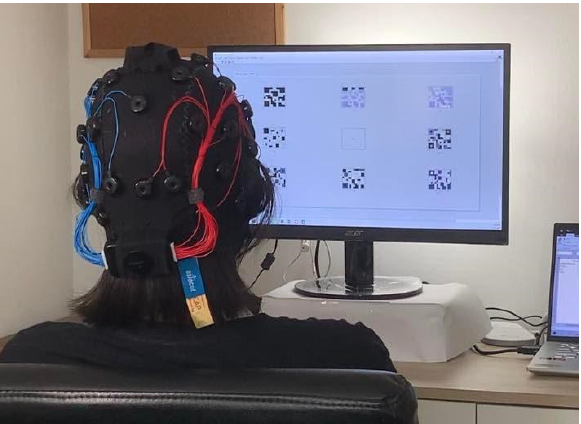
To observe the SSVEP response, the EEGLAB toolbox [43] was used to generate a topographic brain mapping from the PSD, in order to visualize the SSVEP features be- tween conventional and proposed visual stimulus patterns. We visually observed each type of visual stimulus pattern, according to the topographic mapping of the average nor- malized power (shown in Figures 7 and 8). The occipital response, i.e., an area of the SSVEP stimulation response, was observed. The electrode positions of interest in the oc- Figure 6. Experimental setup during QR code flickering pattern stimulation. cipital region were PO3, PO4, POZ, O1, O2, and Oz. Figure 6. Experimental setup during QR code flickering pattern stimulation.